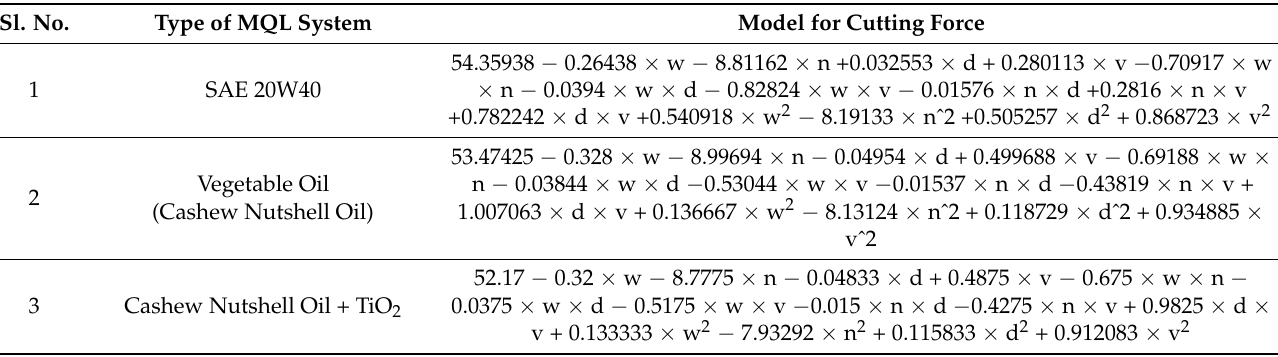
Table 6. Model for cutting force.